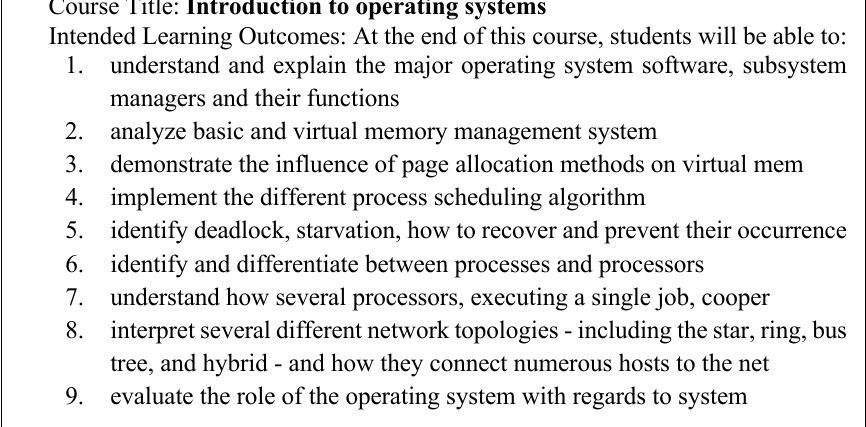
Fig. 6. Learning Objective for Introduction to Operating